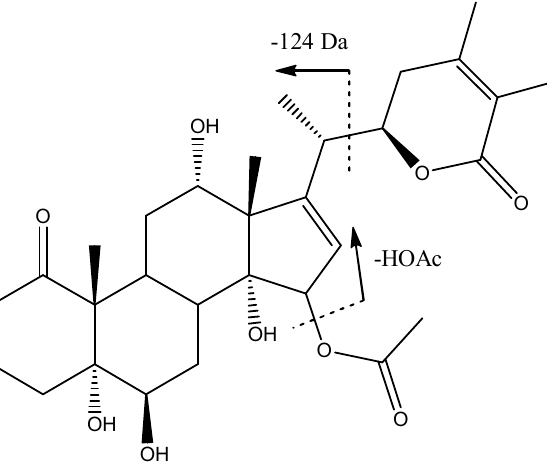
Figure 8. Structure and fragmentation of Physagulin O.